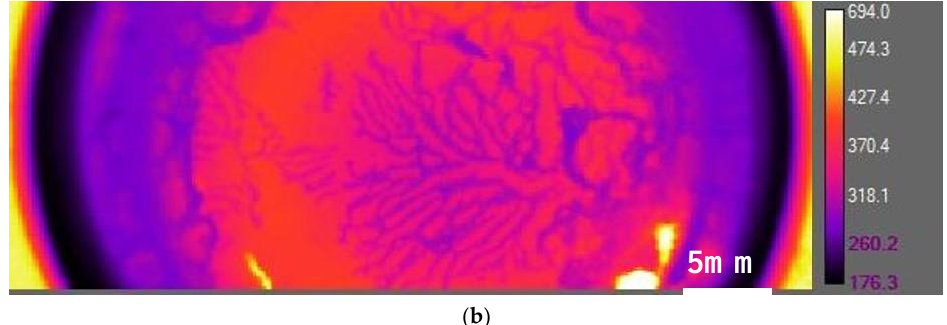
Figure 1. Photographs of the ( a ) not-pretreated and ( b ) pretreated samples during combustion, taken using an IR camera at 70 °C.